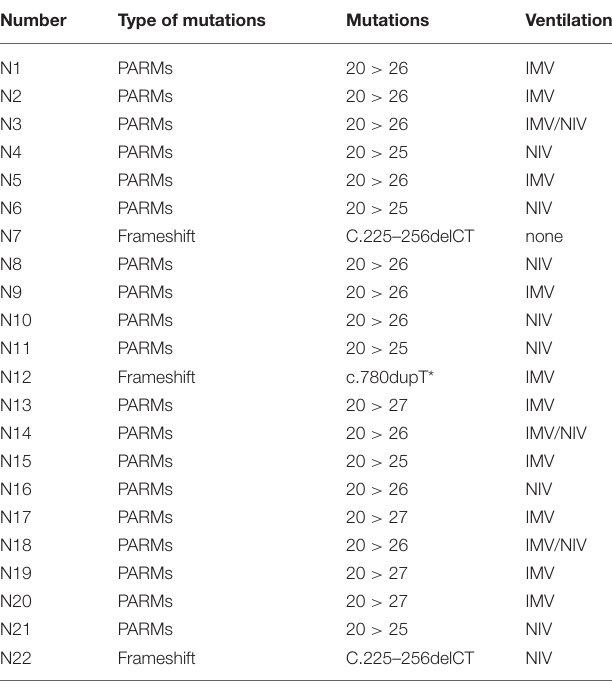
TABLE 2 | PHOX2B gene mutations and ventilation mode for 22 of our